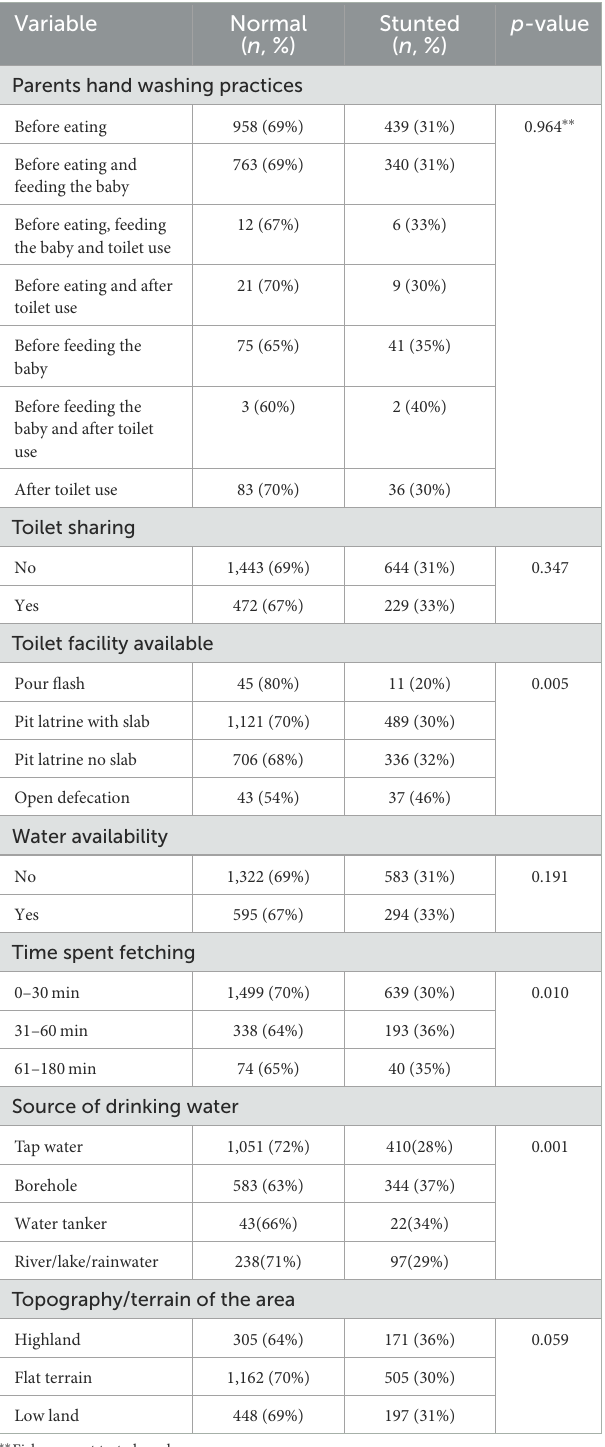
(Table 3). Among the environmental factors, the use of tap water reduced the odds of stunting by 75% (95% CI: 0.59–0.94) while children from households that had no sanitation facilities (aOR: who had flush pour toilets (Table 3). Among the contextual